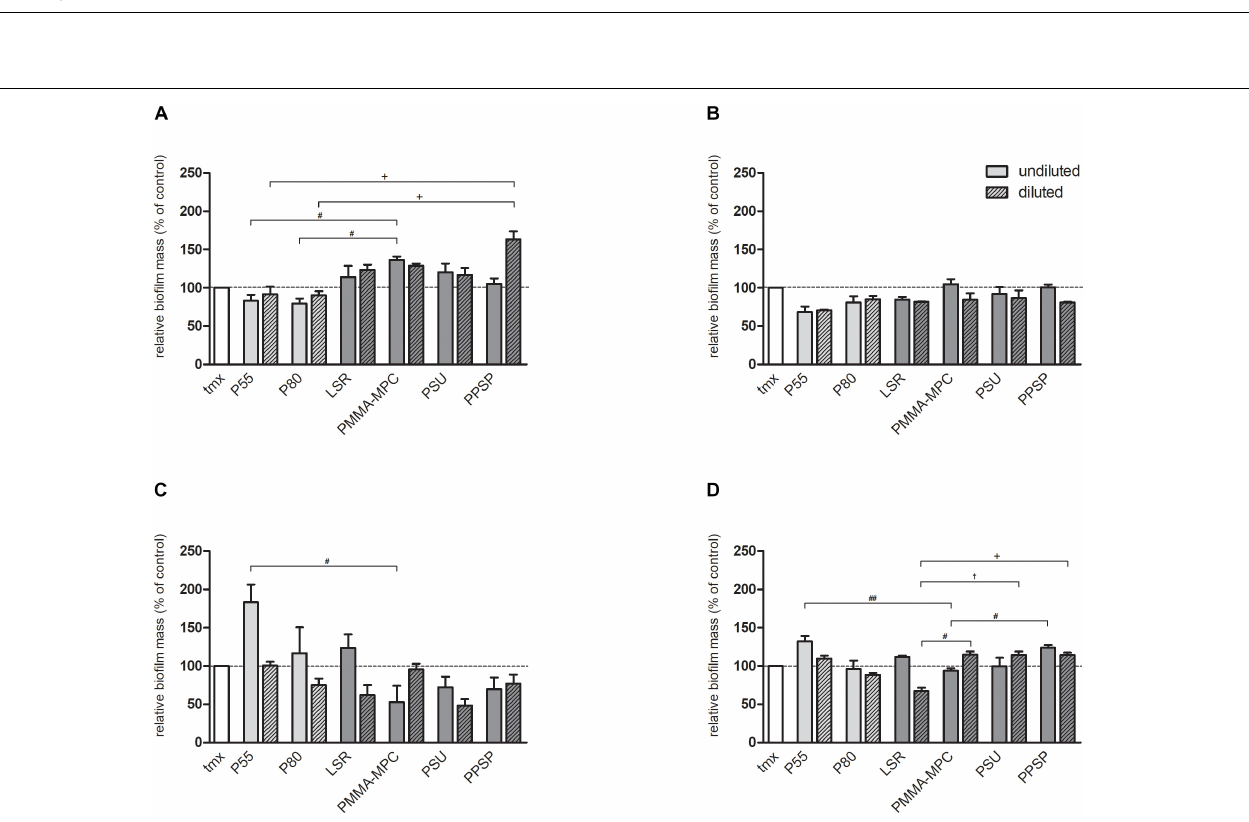
FIGURE 7 | Soluble material components do not inhibit biofilm formation of S. aureus and S. epidermidis. 2 × 10 8 cfu of (A) S. aureus 24 h and (B) S. aureus 48 h (C) S. epidermidis 24 h and (D) S. epidermidis 48 h were incubated with undiluted and diluted eluates from the materials and biofilm formation was quantified after 24 and 48 h by crystal violet staining. Values were normalized to tmx control (100%). Data are represented as mean + SE Mean of three independent experiments carried out in duplicates. Significances: # vs. PMMA-MPC: # p < 0.05, ## p < 0.01; † vs. PSU: † p < 0.05; + vs. PPSP: + p < 0.05.